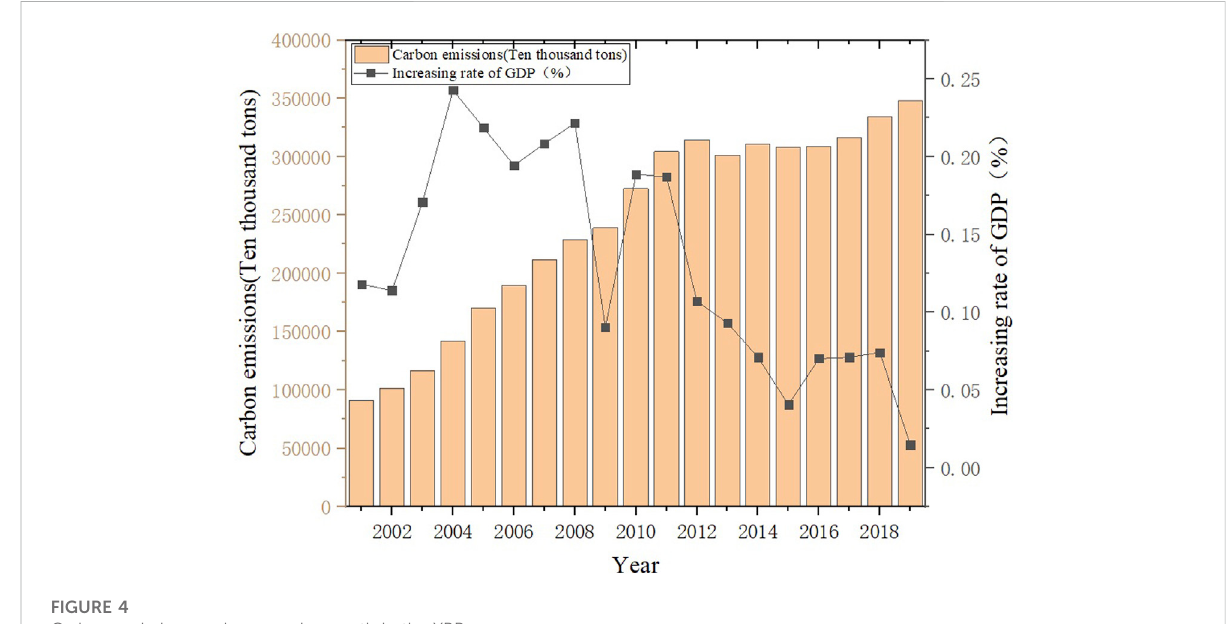
FIGURE 4 Carbon emissions and economic growth in the YRB.